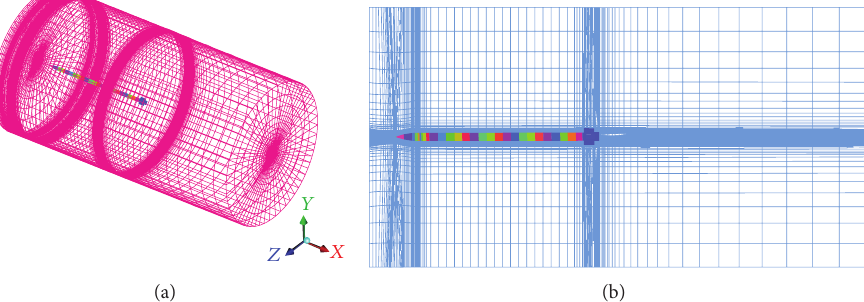
Figure 3: Discrete mesh: (a) flow field grids and (b) the section of